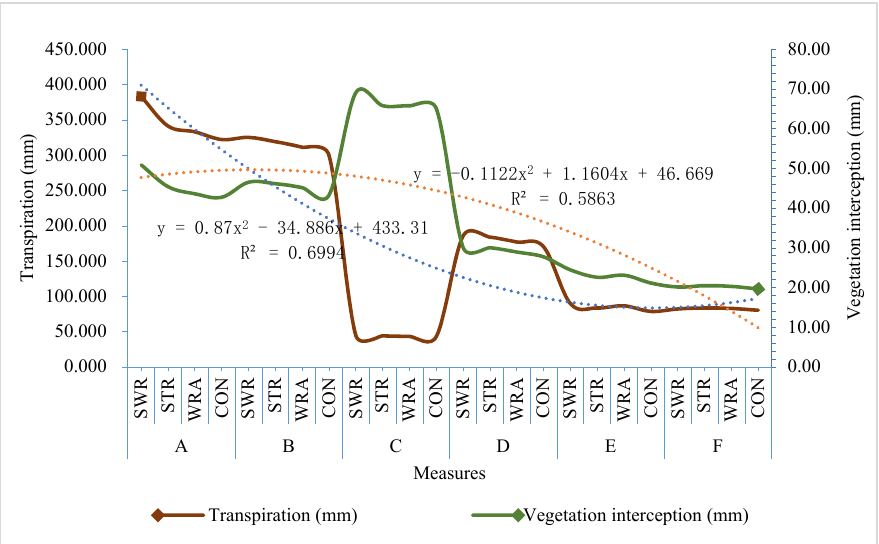
Figure 3. Plant water transpiration and vegetation interception under different measures.